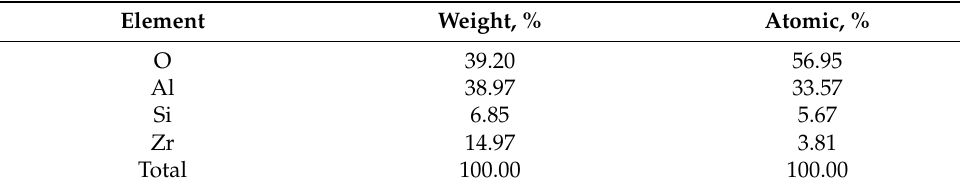
Figure 10. Elemental analysis in point 4 of the sample #4. Table 1. Elemental proportions in point 1 of the sample #4. Table 4. Elemental proportions in point 4 of the sample #4.